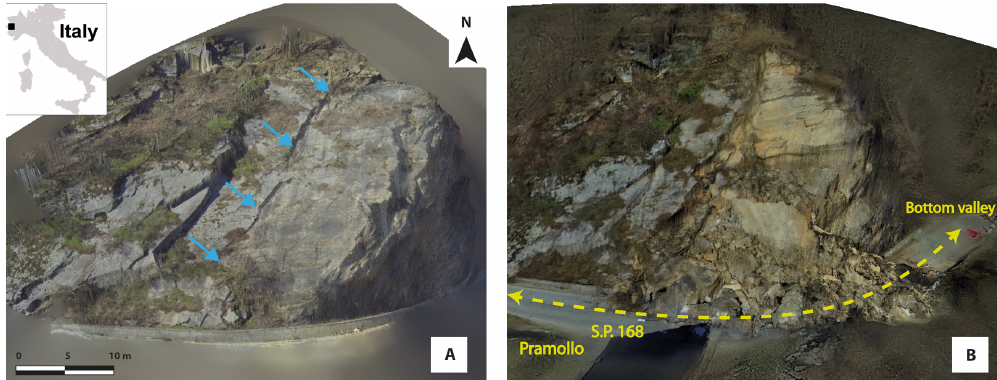
Figure 1. Comparison between 3-dimensional solid images of the study area before (a) and after (b) the San Germano rockfall event. Blue arrows indicate the main lateral fracture. Yellow dashed line indicates the road